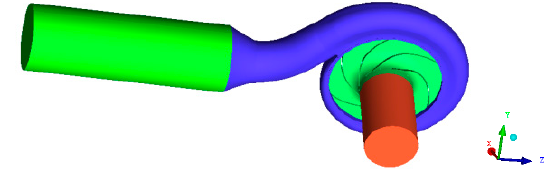
Figure 10. Experimental centrifugal pump.